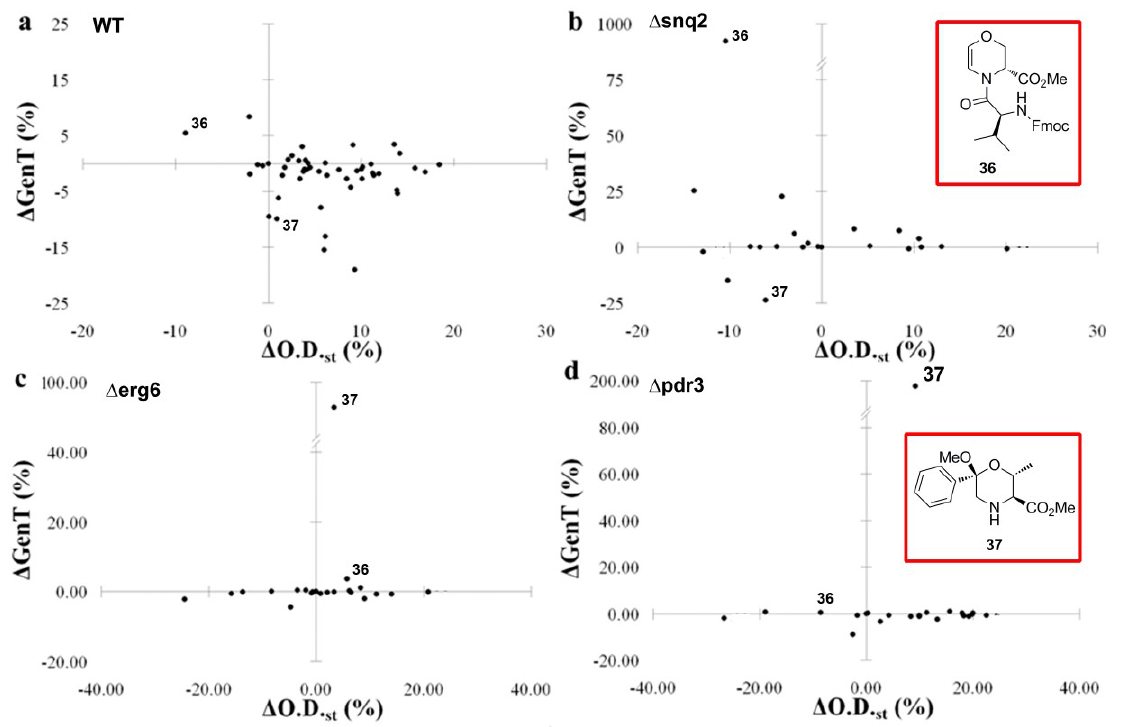
Figure 8. Bidimensional scatter plots showing effects of library members on cell growth of selected deletant strains and structures of compounds 36 and 37 [76]. Cell growth inhibition on ( a ) wild-type strain; ( b ) ∆ snq2 deletant strain; ( c ) ∆ erg6 deletant strain; ( d ) ∆ pdr3 deletant